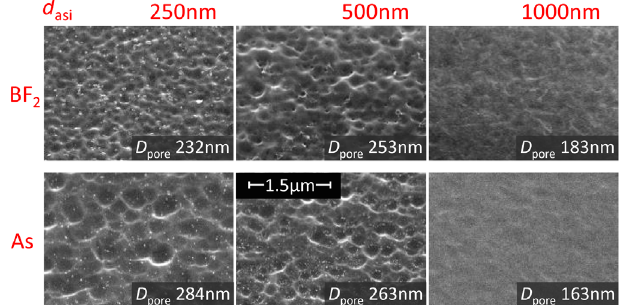
Fig. 6. SEM images and D pore values of sacri fi cial layers implanted with BF 2 and As, with d asi varied between 250 – 500 – 1000 nm. Implantation occurred at d imp =1e16 cm (cid:3) 2 and E imp = 250